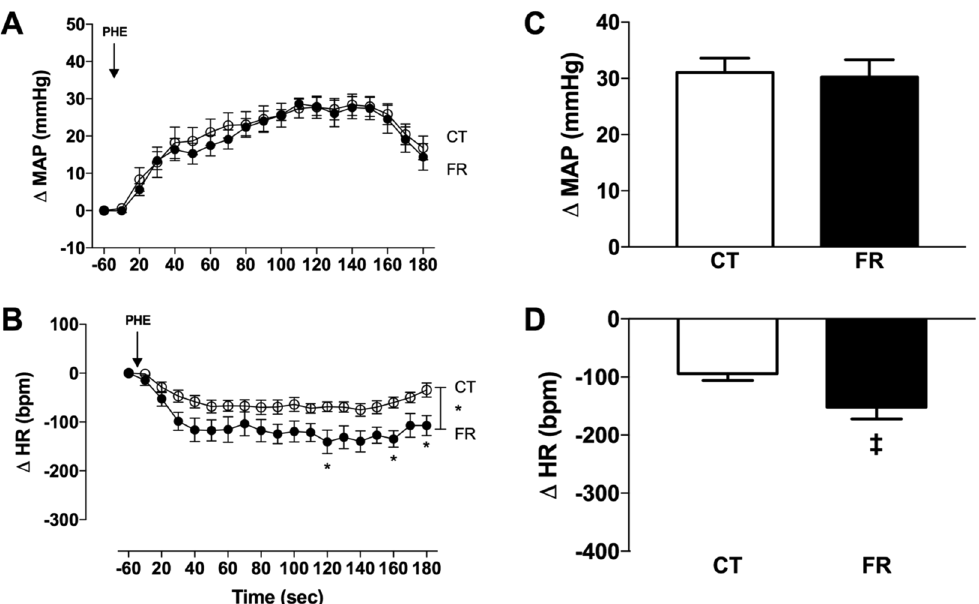
Figure 9. Effect of FR on MAP and HR responses to infusion of phenylephrine (PHE), an α -1 adrenergic receptor agonist. Shown are the changes ( A , B ) or maximum change from baseline ( C , D ) in MAP ( A , C ) and HR ( B , D ) after L-phenylephrine (299 nM/mL, infusion velocity: 2.2 mL/h) in CT (open circle) or FR (closed circle) rats (n = 9/group). Basal MAP (mm Hg): CT, 116 ± 3 vs. * FR, 106 ± 3. Basal HR (bpm): CT, 372 ± 15 vs. FR, 396 ± 14. * P < 0.001 vs. CT by two-way ANOVA and Bonferroni post-hoc test (time; diet); ‡ P < 0.05 vs. CT, by unpaired Student’s t- test; Values are expressed as the mean ±